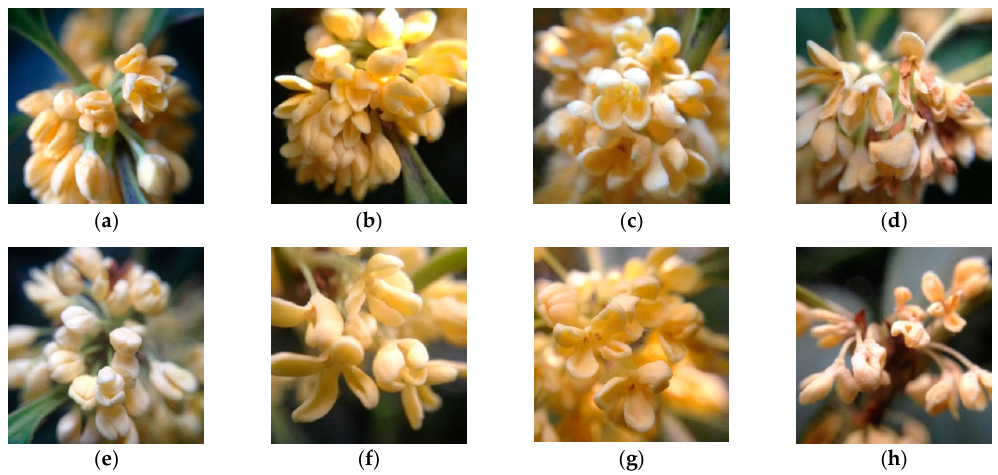
Figure 2. Flowering stages of “Boye Jingui” in ( a ) bud ‐ eye stage (S1), ( b ) primary blooming stage (S2), ( c ) full blooming stage (S3), ( d ) flower fading stage (S4). Flowering stages of “Rixiang Gui” in ( e ) bud ‐ eye stage (S1), ( f ) primary blooming stage (S2), ( g ) full blooming stage (S3), ( h ) flower fading stage (S4).